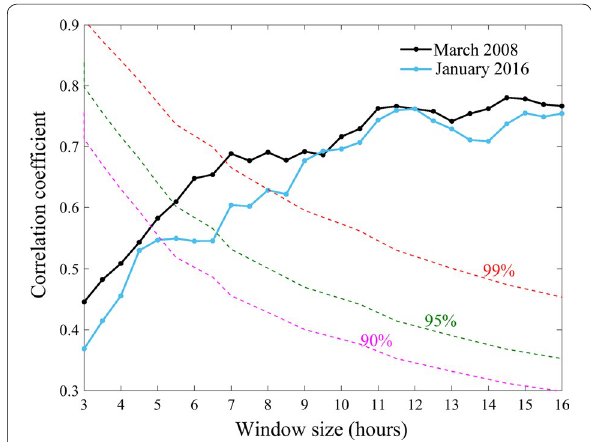
Fig. 12 Correspondence time scales. The correlation coefficients between model and experimental data computed in different time windows. The black and blue lines refer to March 2008 and January 2016,